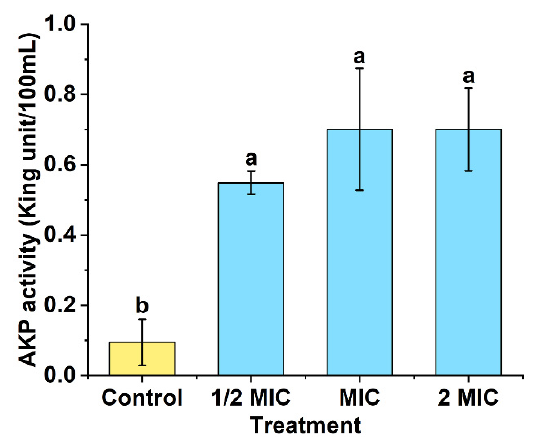
Figure 8. Changes of extracellular alkaline phosphatase (AKP) activity of Pectobacterium carotovorum subsp. carotovorum after treatment with Polygonum orientale essential oil (concentration: 1/2MIC, MIC, and 2MIC). The group treated with DMSO (2%) served as the control. A significant difference was expressed ( p < 0.05).